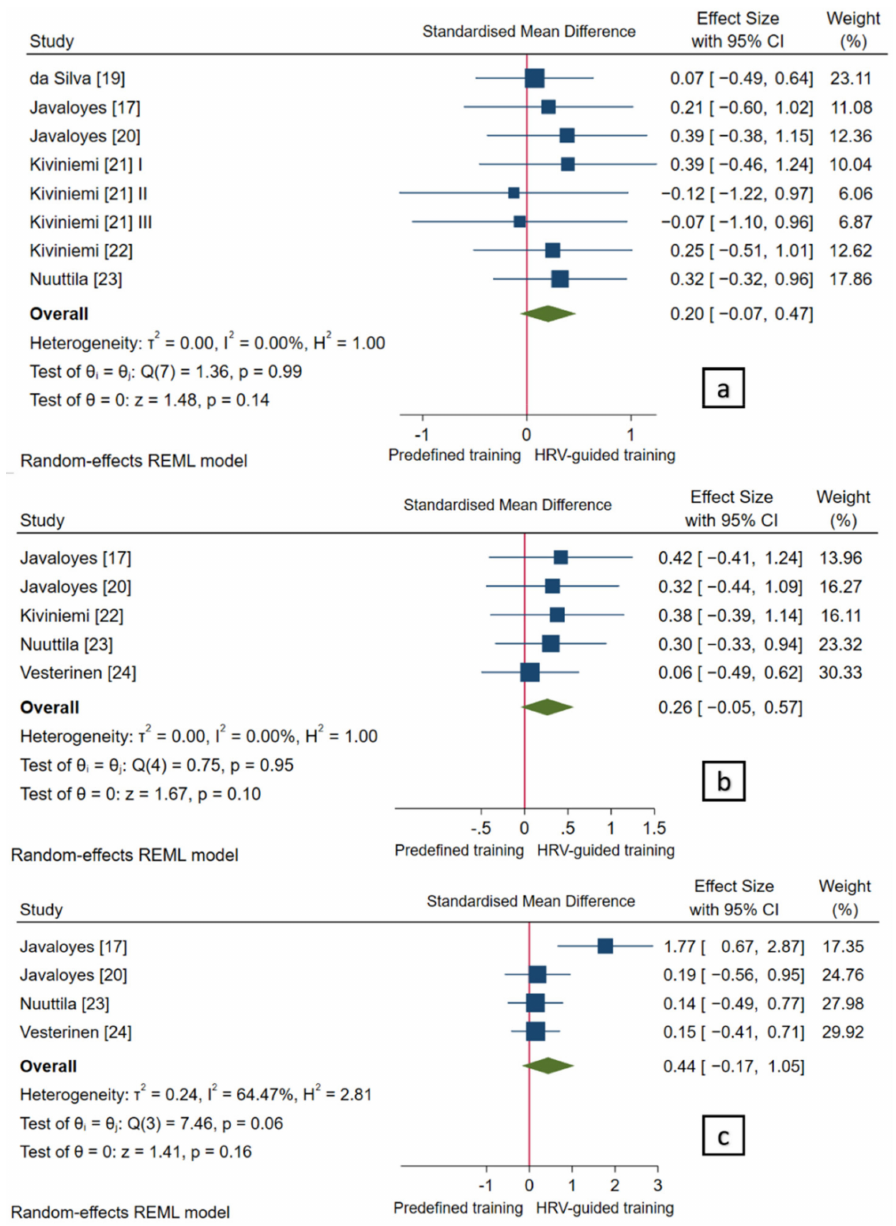
Figure 5. Forest plot of standardized mean difference indices for ( a ) maximal aerobic capacity, ( b ) aerobic capacity at second ventilatory threshold, and ( c ) aerobic capacity at first ventilatory threshold. I, II, III refer analysis units from the same